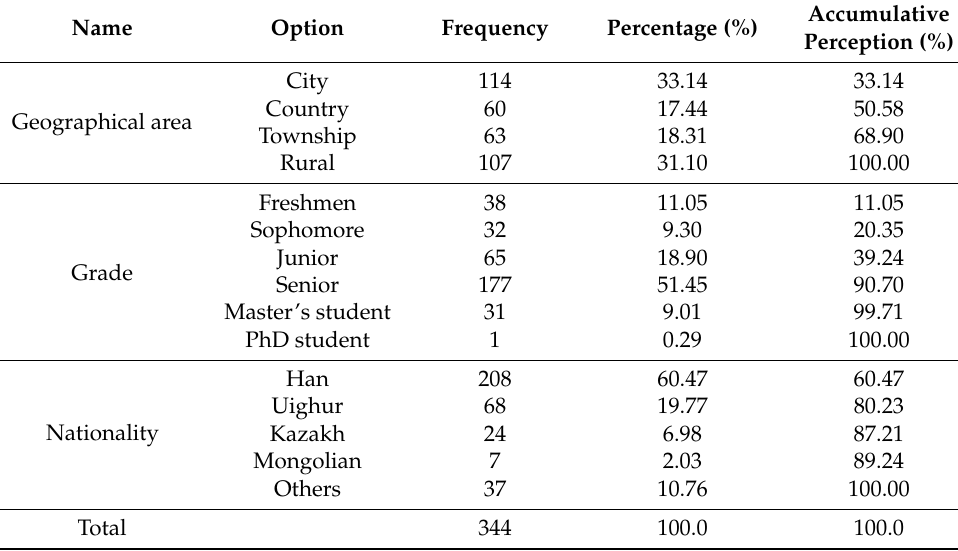
Table 2. Summary of demographic characteristics of the study